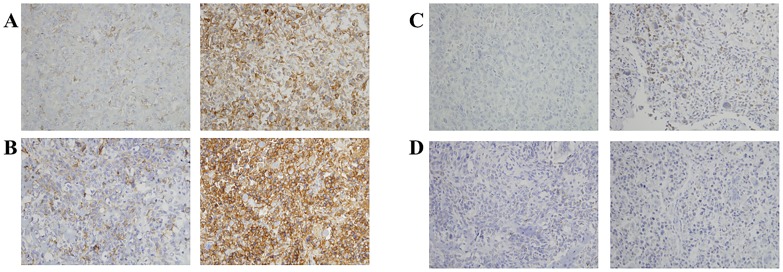
Immunohistochemistry of paired canine primary (left) and metastatic (right) in two different patient samples showing the expression of (A-B) CD44 and (C-D) CD147.p values for A and B p < 0.05 with metastatic > primary. p values for C p < 0.01 with metastatic > primary. Details of quantification are indicated in SI.